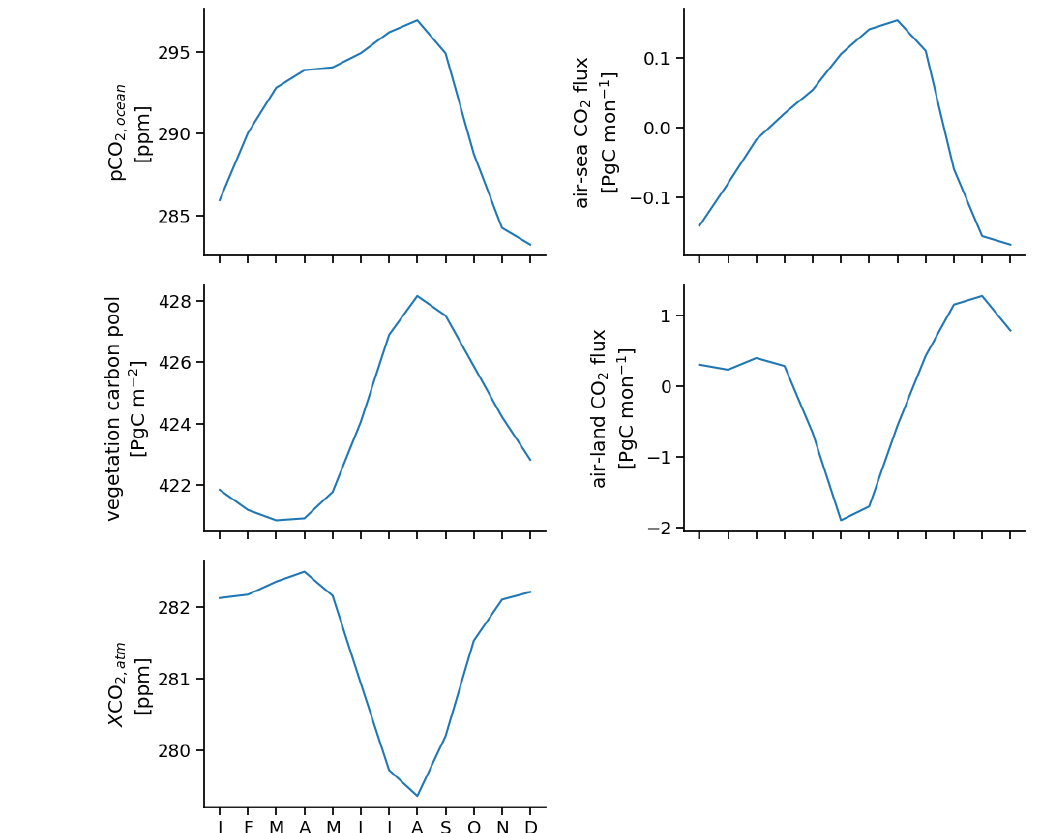
Figure E1. Seasonality of the target simulation for global aggregated carbon cycle variables.